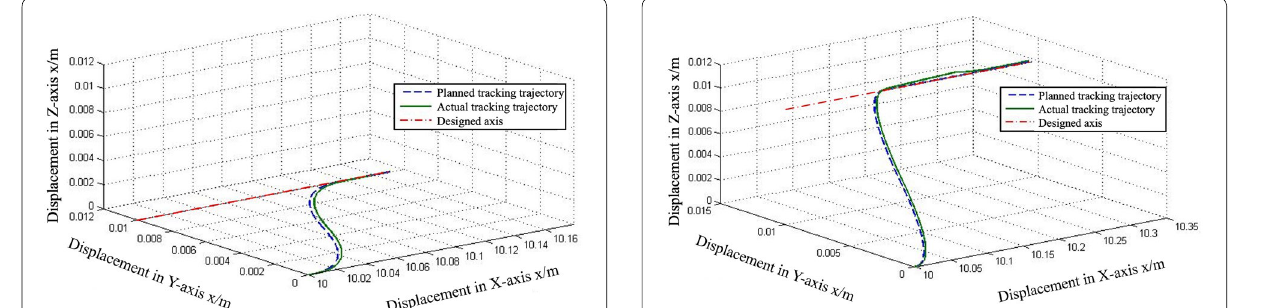
Figure 13 Tracking trajectory when deviation in both Y -axis and Z